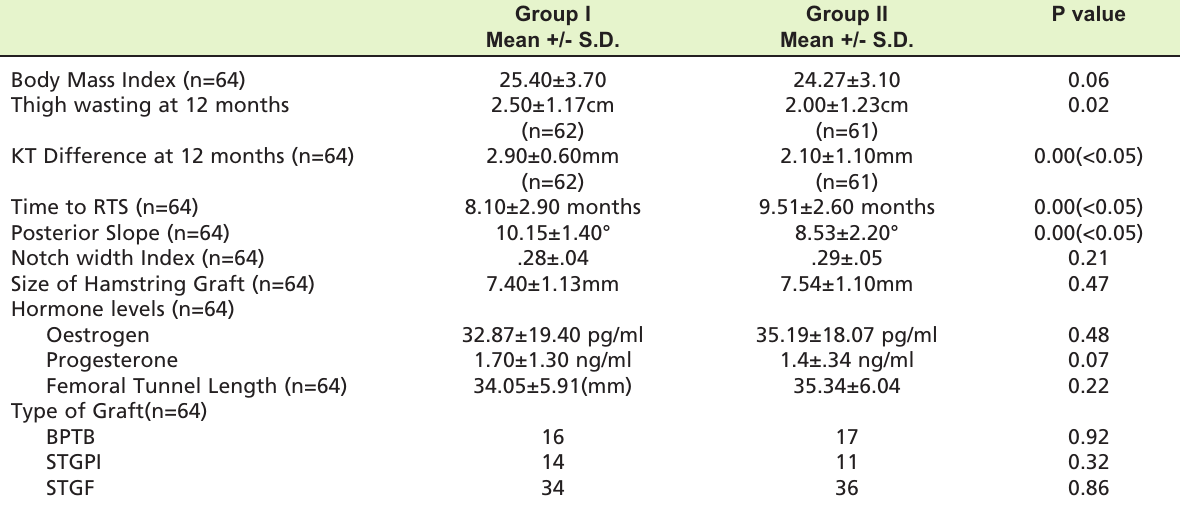
Comparison of continuous variables between two groups Table I: